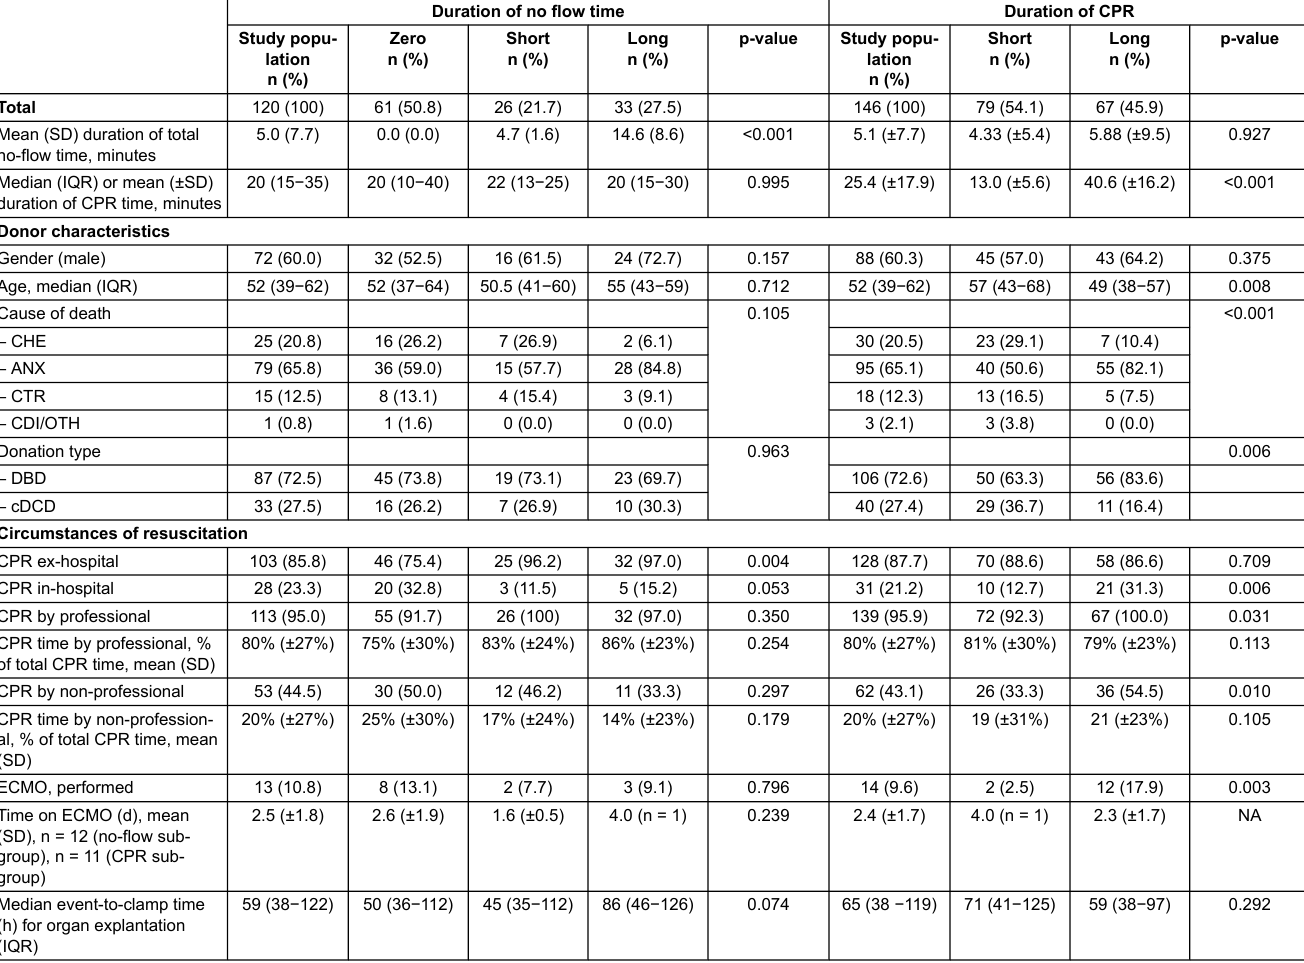
Table 2: Baseline characteristics and selected circumstances of cardiopulmonary resuscitation (CPR) of utilised donors for whom data on duration of no-flow time and CPR were